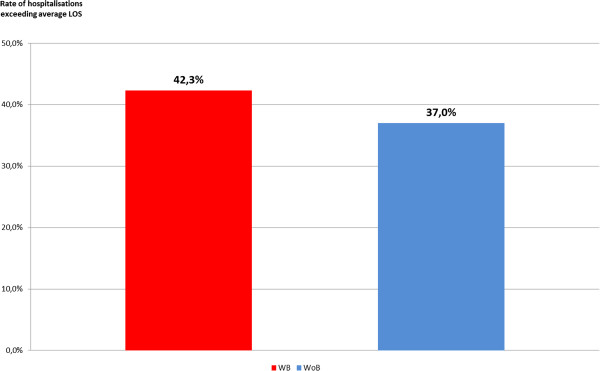
Percentages exceeding average LOS.